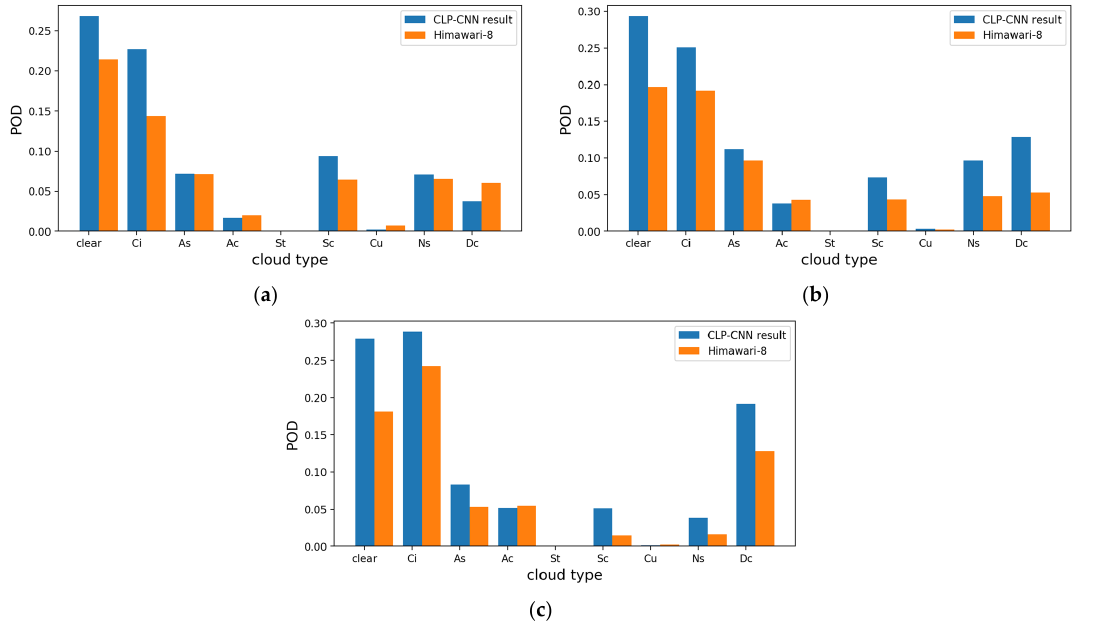
Figure 13. ( a ) Comparison of CLP-CNN results and Himawari-8 products with CloudSat from January to February; ( b ) comparison of CLP-CNN results and Himawari-8 products with CloudSat from March to May; ( c ) comparison of CLP-CNN results and Himawari-8 products with CloudSat from June to July. By comparing the output results of the CLP-CNN and Himawari-8 products shown in Figure 13 with CloudSat, it can be found that the output results of the CLP-CNN net- work are worse than those of the Himawari-8 products only in the classification of AC- type clouds. In the regions with different classifications, the cloud classification results of CLP-CNN are closer to those of CloudSat. The reason for this problem is also the differ- ence between the satellites and the feature extraction abilities of the CLP-CNN network for long-term sequence data. Therefore, the CLP-CNN network has a good classification effect on the observation data of geosynchronous satellites. 5. Conclusions In this paper, the CLP-CNN network is proposed, a CNN network that can be used for cloud classifications of satellite observation images. This model combines an attention mechanism, a residual network, and an ASPP module to improve the classification abili- ties of the network. After training, the CLP-CNN achieved an 84.4% accuracy compared with the Himawari-8 cloud classification products; when evaluated with CloudSat 2B- CLDCLASS, the CLP-CNN output was superior to the Himawari-8 products for various cloud types. Compared with many excellent classification models in the field of remote sensing, the CLP-CNN network achieves the best results. The model only needs 0.9 s to perform the cloud classification task on the FY-4A AGRI observation image with 800 × 800 pixels without manual intervention and professional knowledge. However, the CLP-CNN network has some shortcomings. Because of the influence of CloudSat’s running orbit and running time, we cannot introduce more accurate cloud classification data into the train- ing process. We plan to further improve our label dataset in the future to make it more